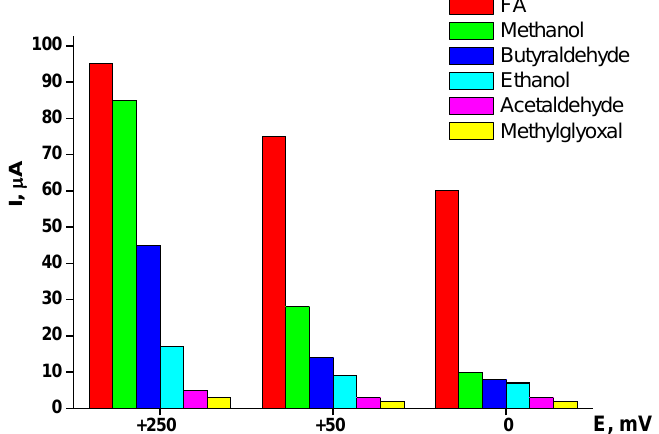
Figure 2. Amperometric response of the chemosensor based on a 3.05 mm rod platinized carbon electrode for various analytes at different working potentials: +250 mV, +50